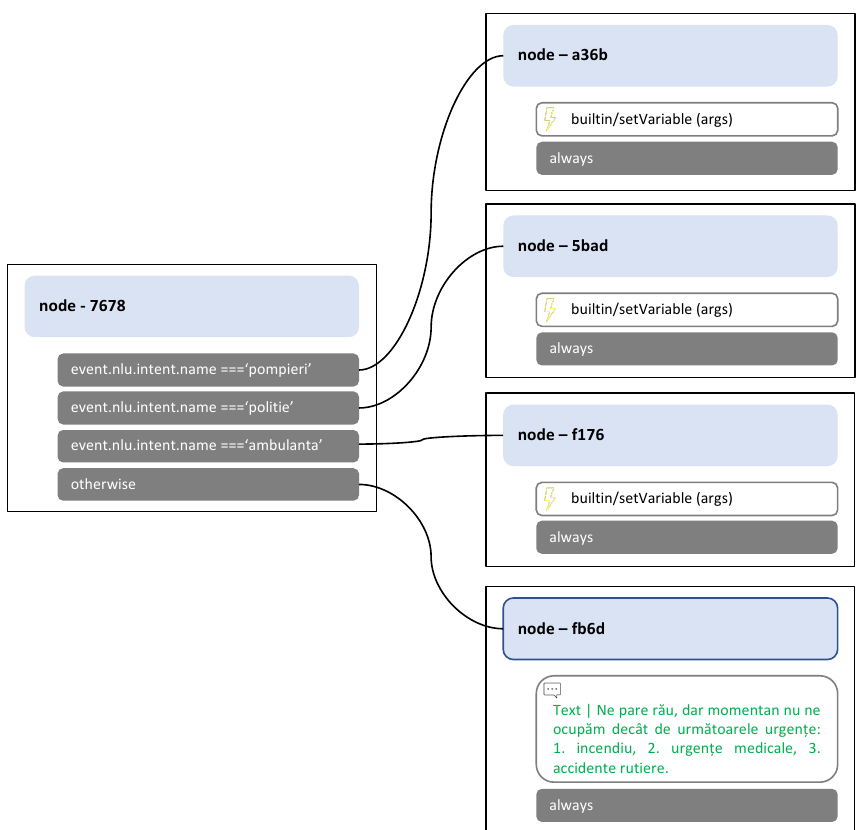
Figure 3. BotPress PoC business logic